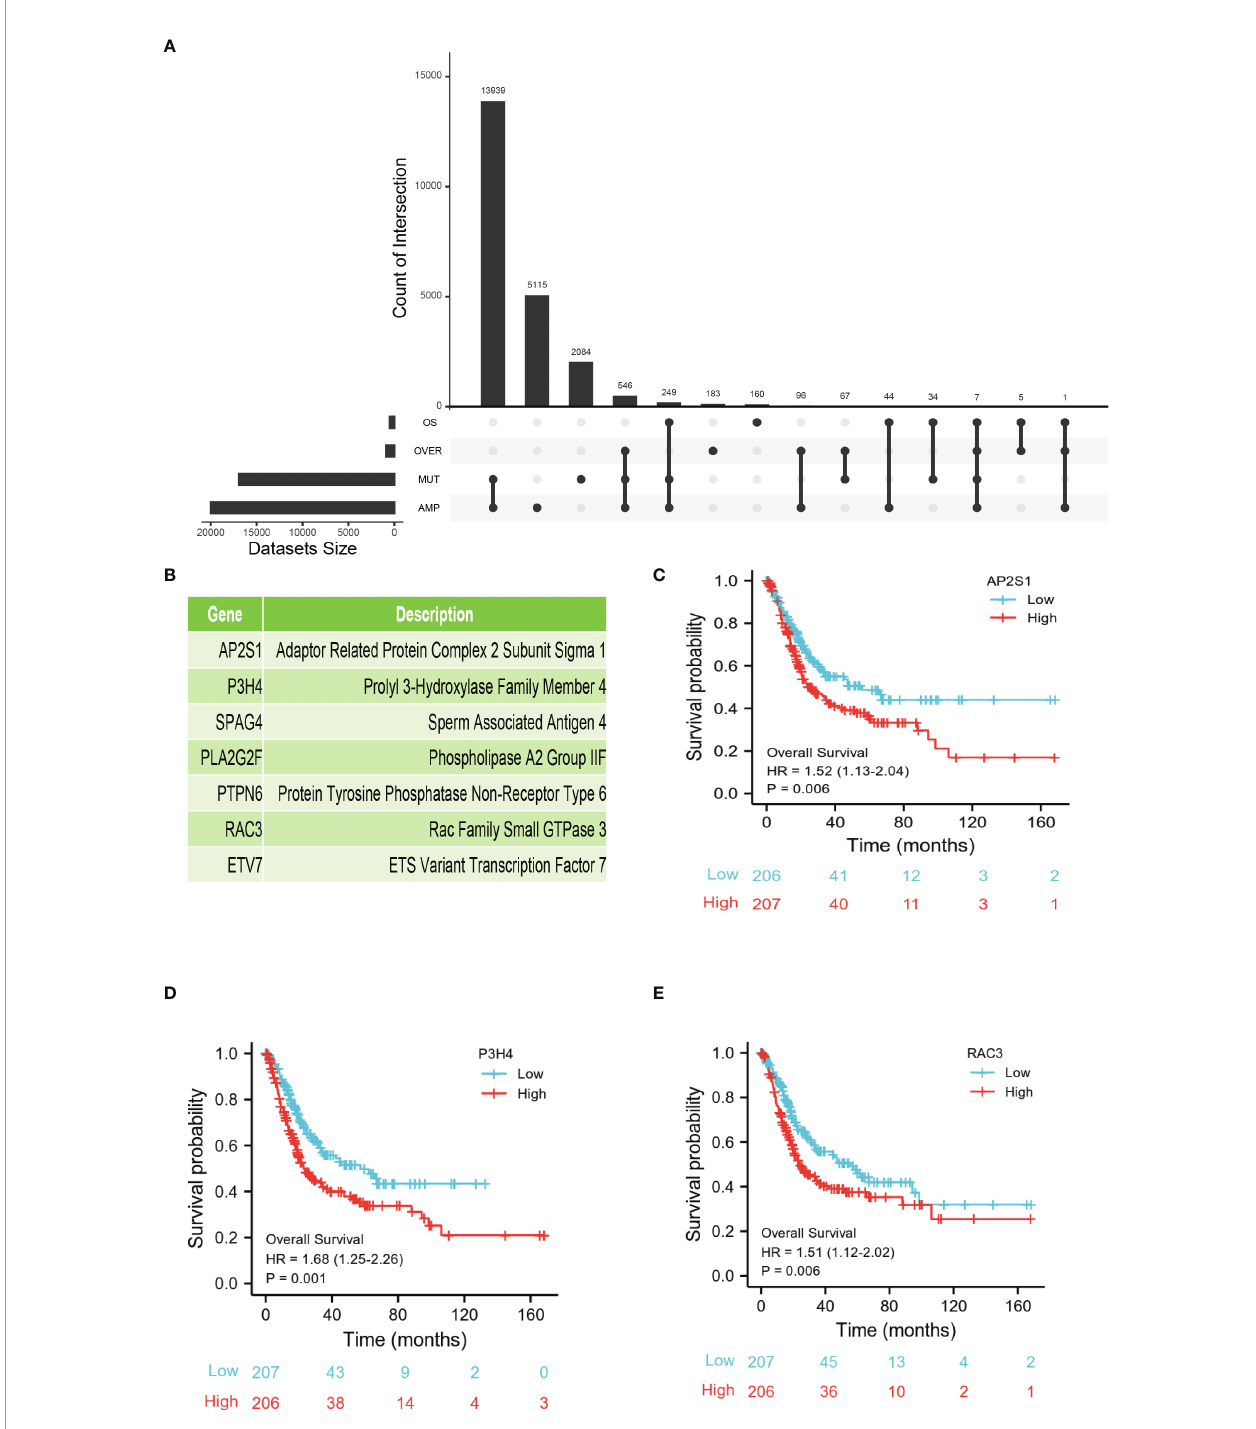
FIGURE 2 | Identi fi cation of tumor-speci fi c antigens related to prognosis of BLCA. (A) Upset diagram shows the number of gene intersections in different groups. (B) Seven candidate protein-coding genes. (C – E) Kaplan-Meier OS of AP2S1 (C) , P3H4 (D) , and RAC3 (E) in